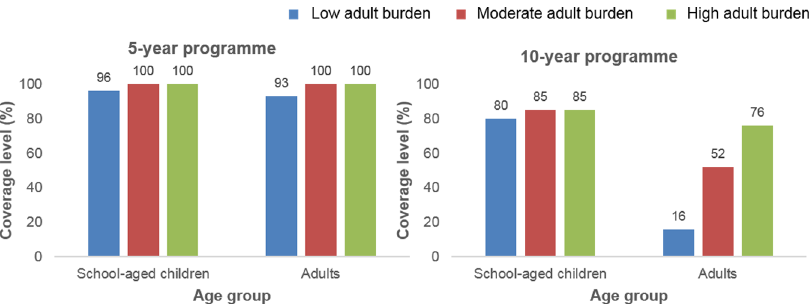
Fig 6. Coverage levels required to reach the World Health Organization (WHO) goal of elimination as a public health problem. High prevalence settings ( (cid:21) 50% SAC baseline prevalence) showing coverage levels of school-aged children (SAC; 5–14 years of age) and adults required to reach the WHO goal of elimination as a public health problem within 5- and 10-year treatment programmes (see S1B Fig for 15-year treatment